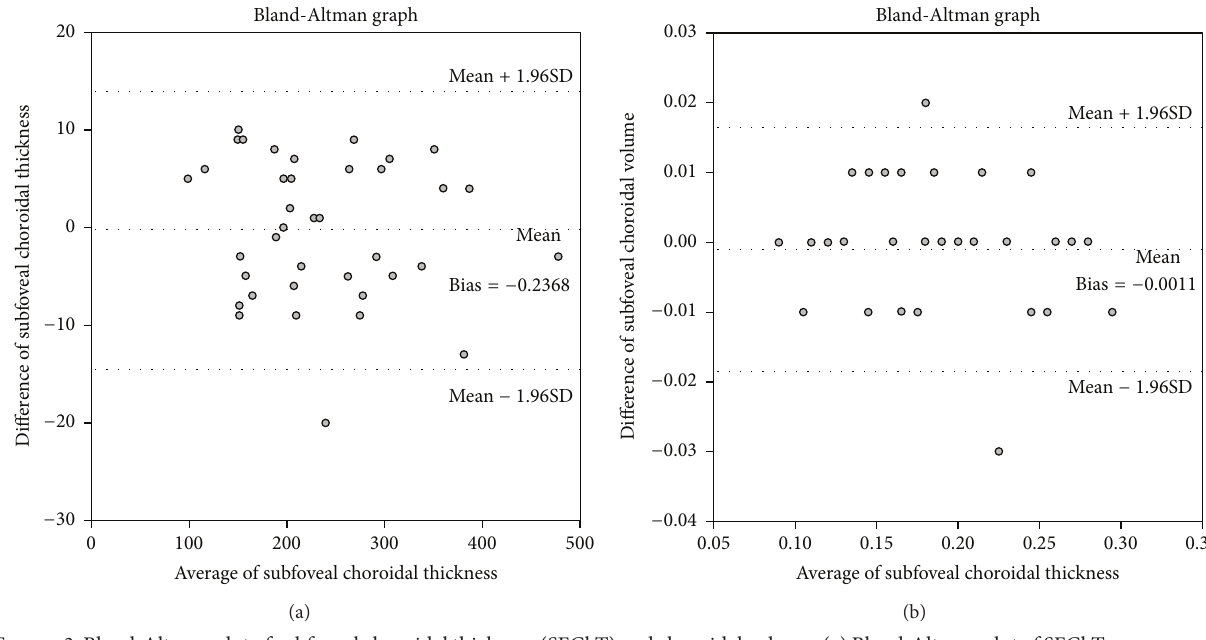
Figure 3: Bland-Altman plot of subfoveal choroidal thickness (SFChT) and choroidal volume. (a) Bland-Altman plot of SFChT measurements taken by two independent retina specialists. No substantial bias was found between the two sets of measurements. The 95% limit of agreement for the SFChT ranged from − 14.40 to 13.93. (b) Bland-Altman plot of choroidal volume measurements showing no substantial bias between the two sets of measurements. The 95% limit of agreement for the choroidal volume measurement ranged from − 0.186 to